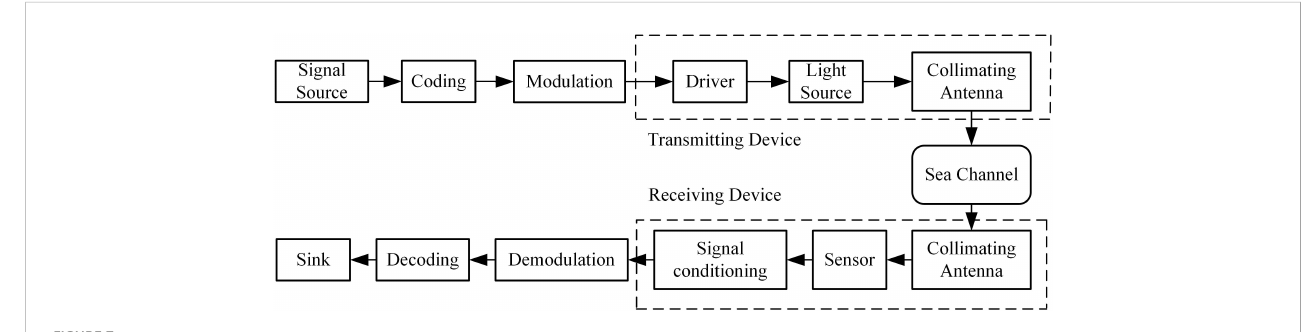
FIGURE 7 The principle block diagram of optical communication.